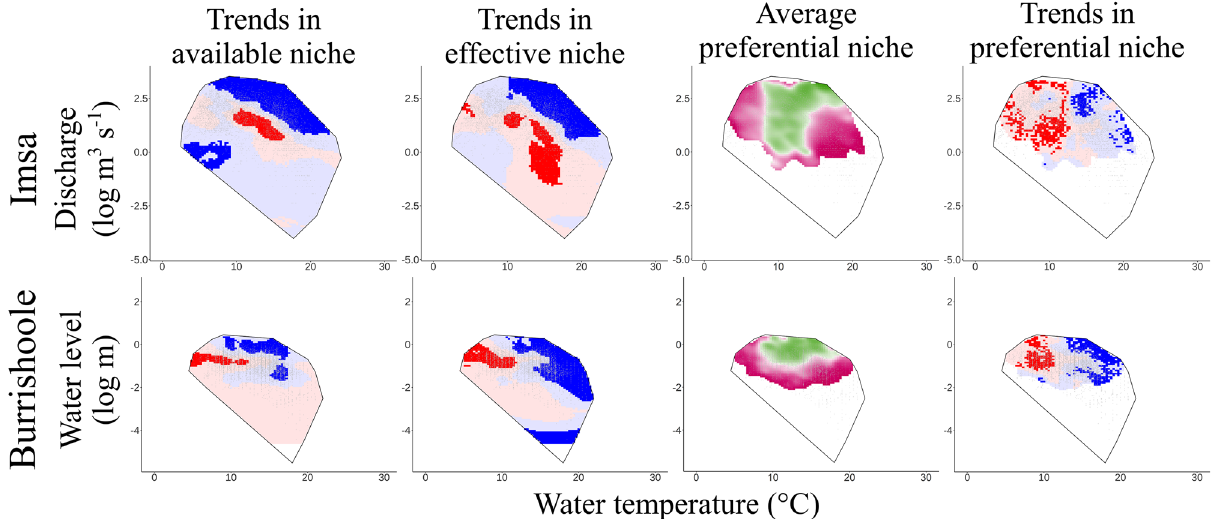
Figure 5. Migratory conditions of silver European eels ( Anguilla anguilla ) from the Imsa (1975–2019) and Burrishoole rivers (1970–2013). Two-dimensional heatmaps of water temperature (X-axis; °C) and log- transformed discharge/water level (Y-axis; log m 3 s −1 or log m) are plotted for the period August to November or less frequent over the study period are shown in blue or red, respectively. Light or dark colours correspond to non-significant and significant trends, respectively. The grey line delineates the convex hull. Within